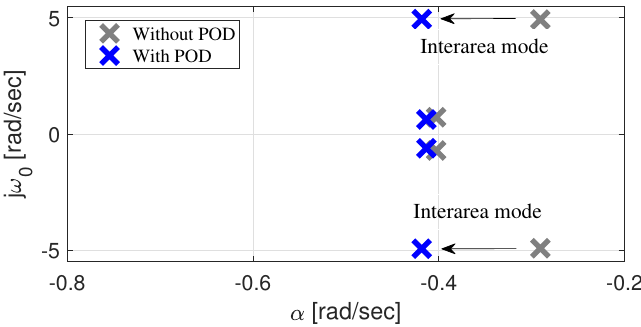
Figure 12. Eigenvalues of the system with AFC (Case C) in parallel with a POD control. The shift of eigenvalues is because of the POD